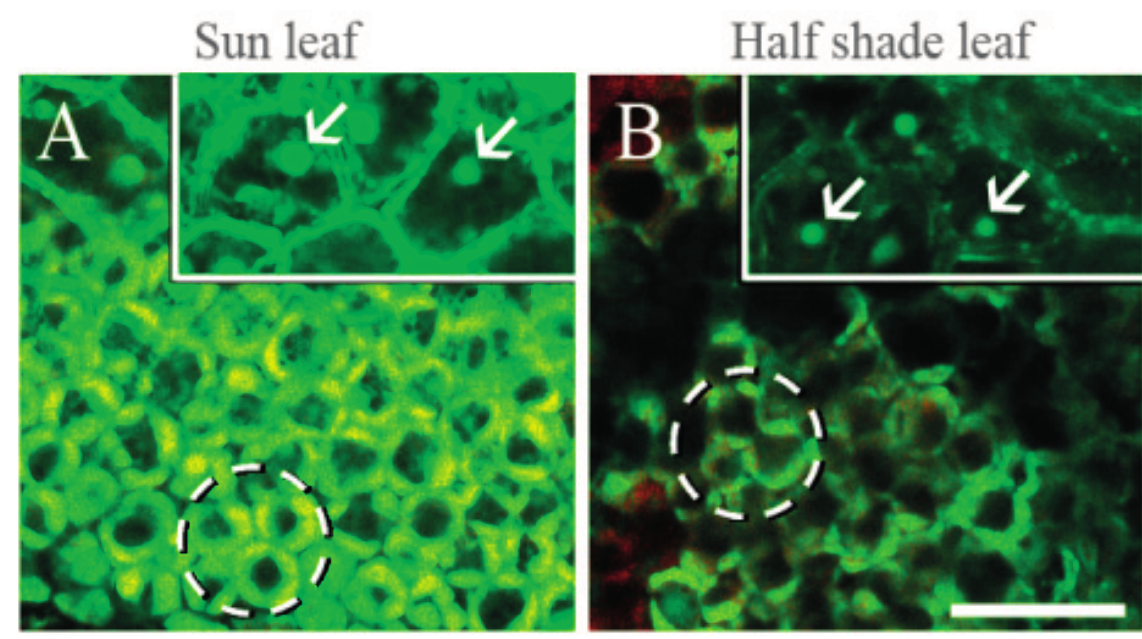
Figure 1. Laser scanning confocal microscopy images of sun exposed ( A ) and half shaded ( B ) Gohér altering leaves with NS-conjugated flavonoid (green) and chlorophyll (red) fluorescence (merged). Circles highlight three representative mesophyll cells from palisade parenchyma regions of sun and half shade leaves. Note the difference in green fluorescence intensity of NS-conjugated flavonoids in these comparable regions (to reduce image saturation, detector sensitivity was reduced 6.4% to capture sun leaf’s intense green fluorescence emission). Insets show lumen of upper epidermis cells with nuclear labeling (arrows). Red chlorophyll fluorescence appears yellow when superimposed with green signals. Scale bar is 30